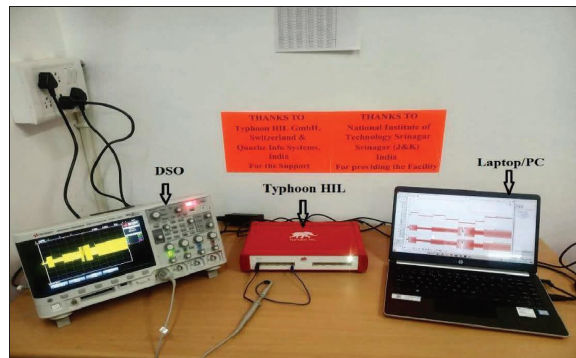
Figure 15: Experimental set-up used during real-time